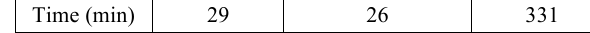
Table 2. Statistics of the batch-mode automatic co- registration of high-resolution image to the HRSC MC11-E mosaic